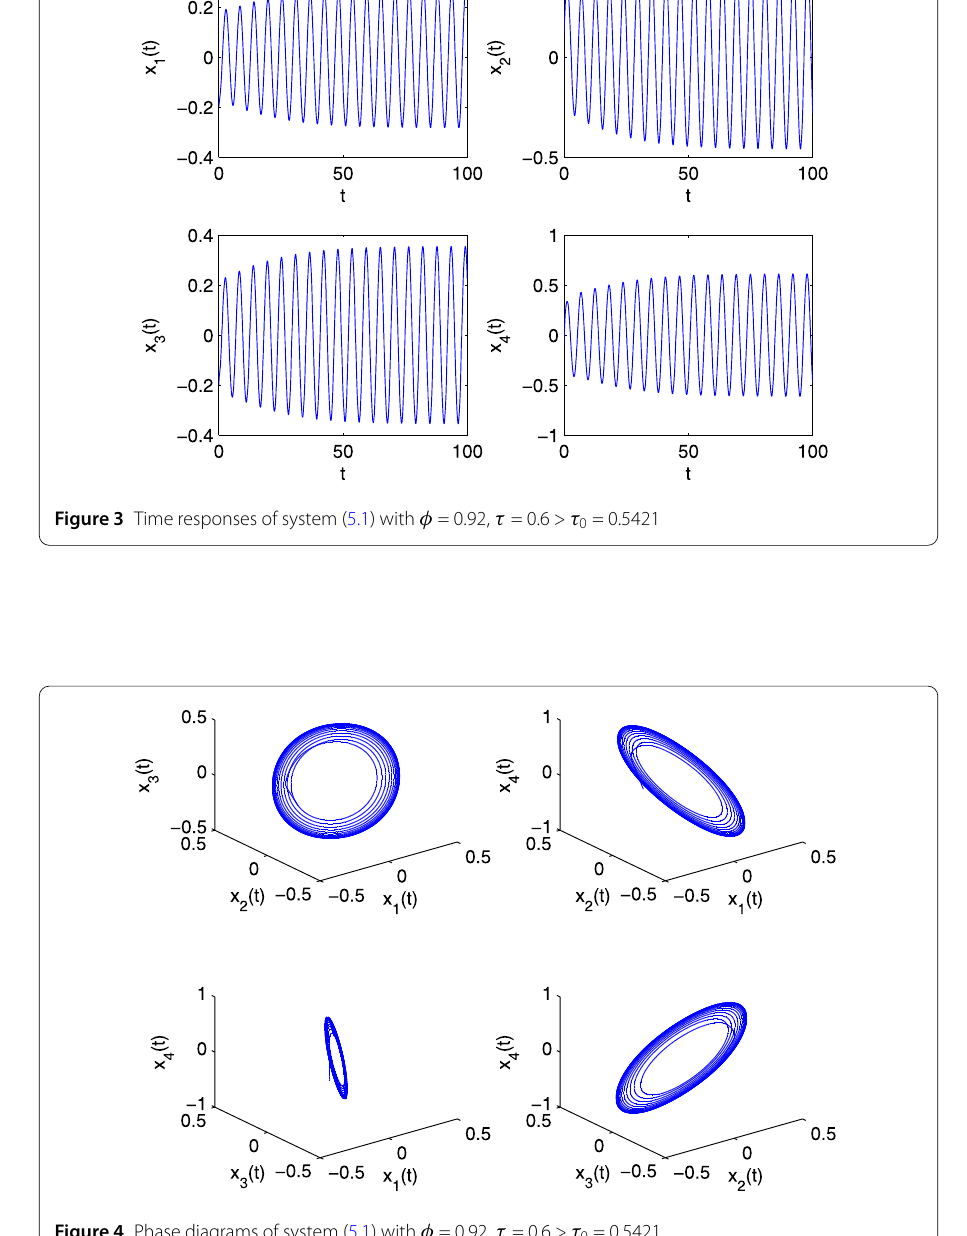
Figure 4 Phase diagrams of system (5.1) with φ = 0.92, τ = 0.6 > τ 0 =